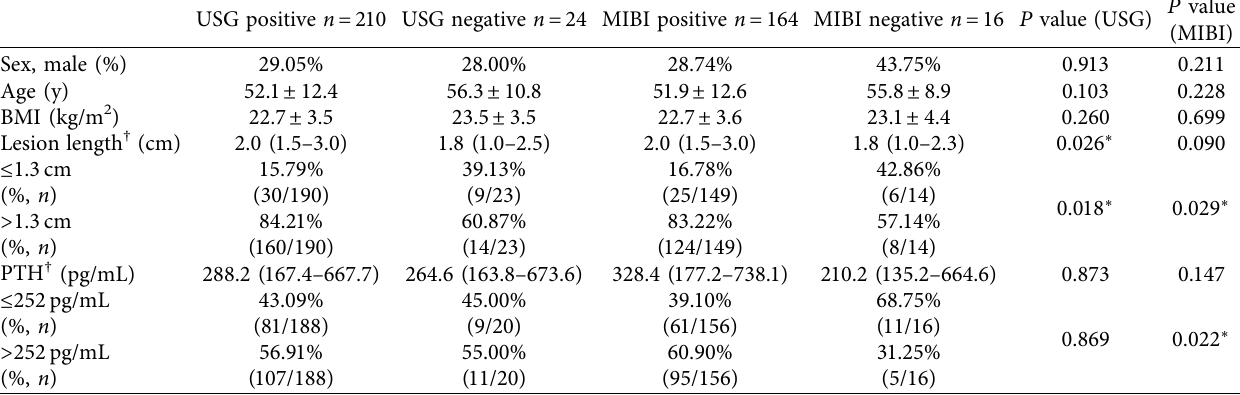
Table 3: Influence of clinical features on cervical ultrasonography and 99mTc-MIBI SPECT/CT in searching parathyroid